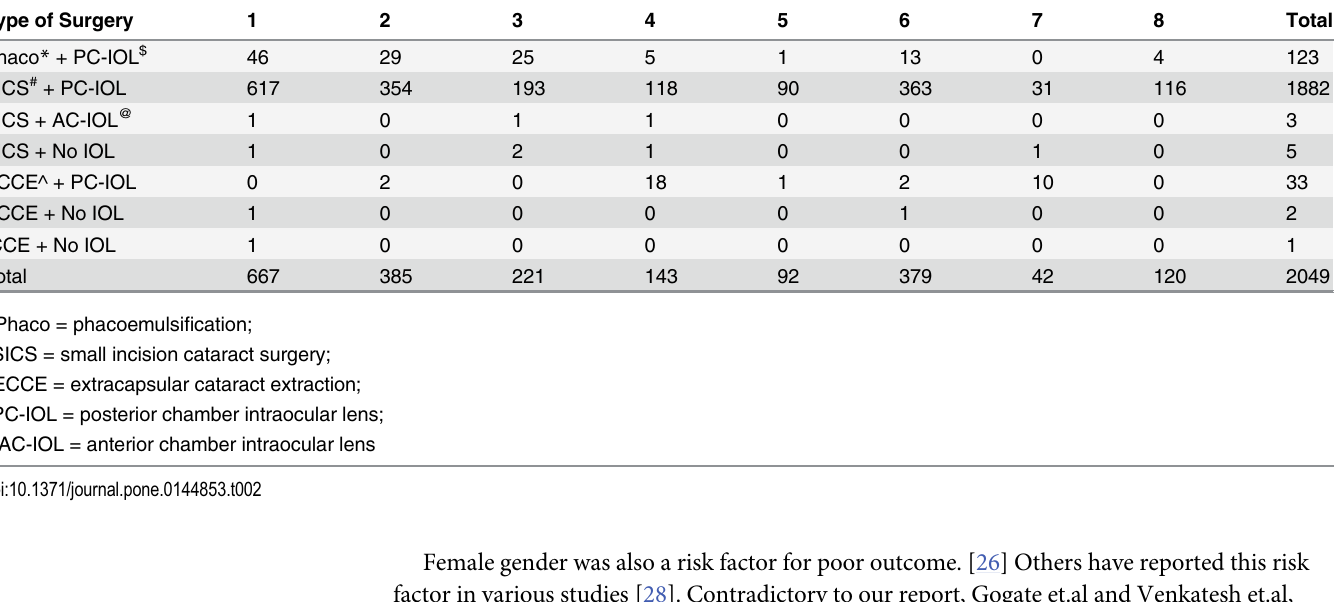
Table 2. Type of cataract surgery performed at each of eight secondary hospitals. Type of Surgery